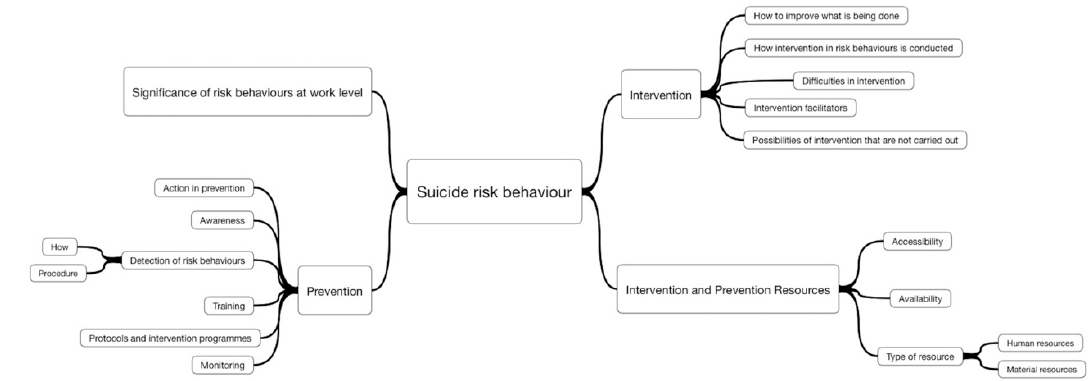
Figure 2. Main categories and subcategories of suicide risk behavior significance.